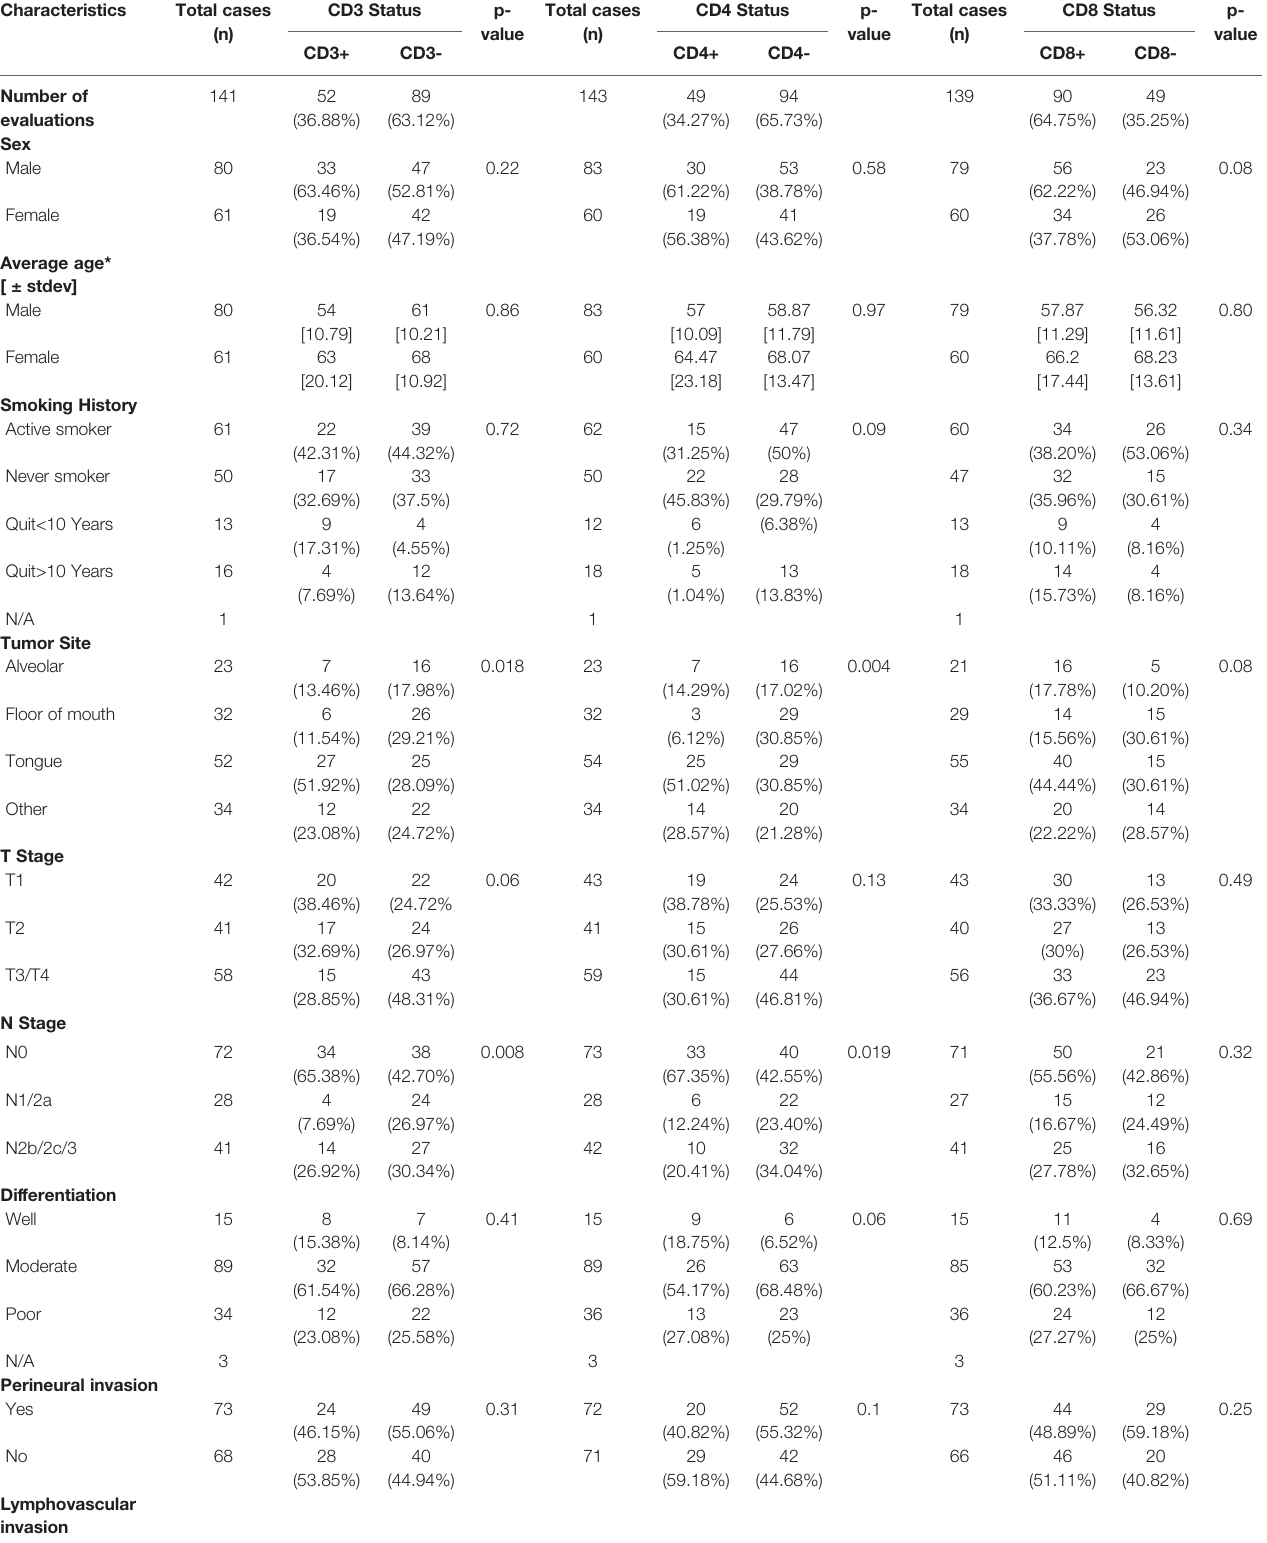
TABLE 2 | Clinicopathological features of patients based on T Cell marker status.